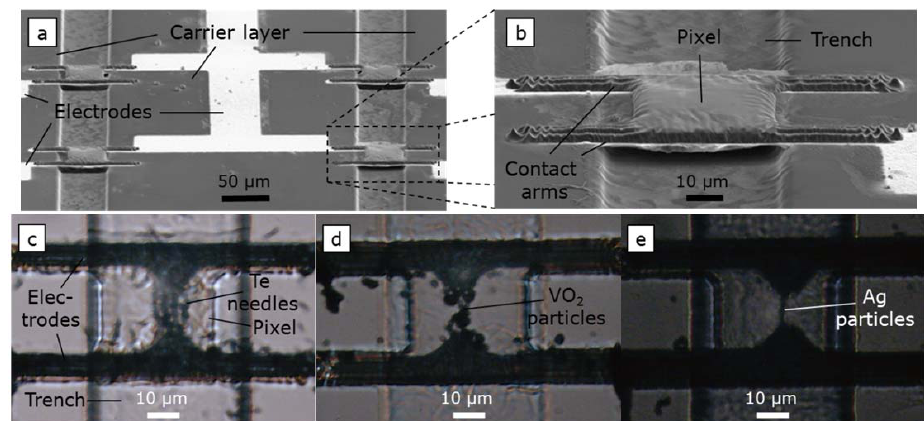
Figure 6. Microscopic pictures of the polymer composite based microbolometers realized: SEM-views of (a) the 2 × 2 array, and (b) a magnified individual pixel with a sensitive layer containing aligned silver particles, view of the structures at a tilting angle of 75 ◦ across the top view; optical microscopic pictures of individual pixels with aligned (c) tellurium needles, (d) vanadium dioxide particles and (e) silver particles in the sensitive polymer composite.